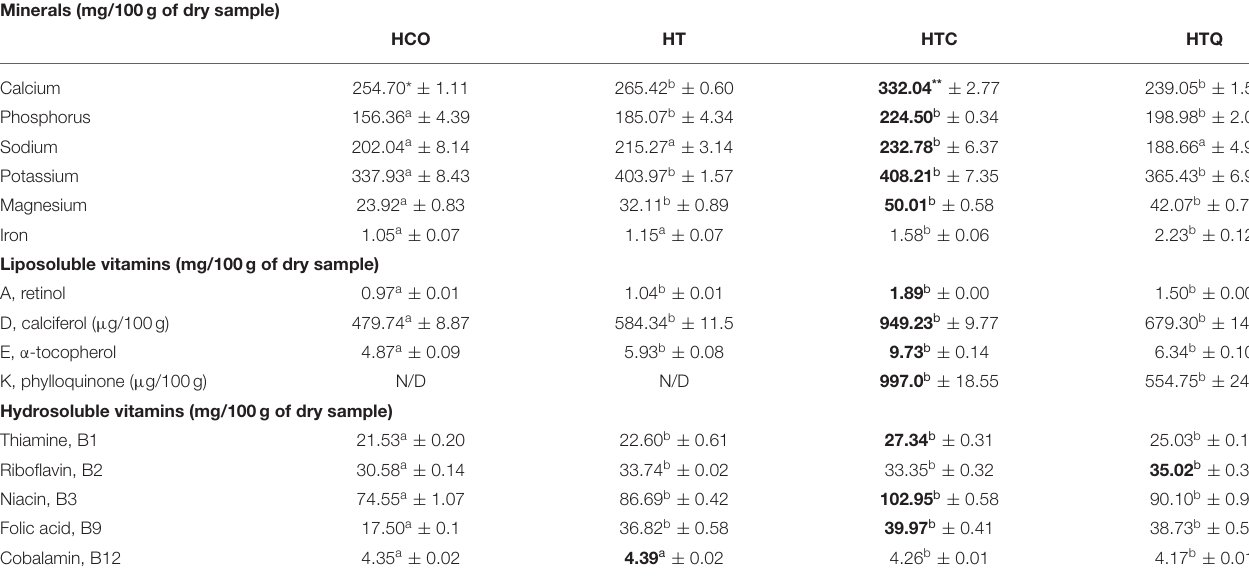
TABLE 4 | Profiles of minerals and vitamins quantified in the manufactured formulations. Minerals (mg/100g of dry